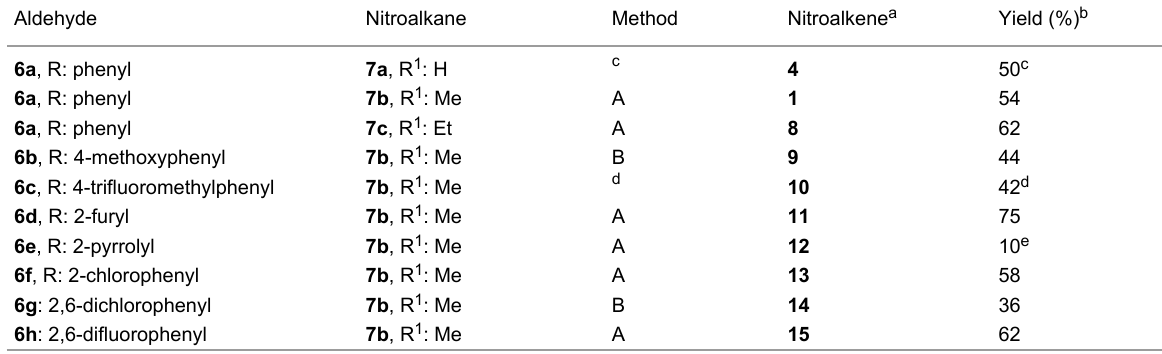
Table 3: Preparation of 1-aryl-2-nitroalkenes. Aldehyde Nitroalkane Method Nitroalkene